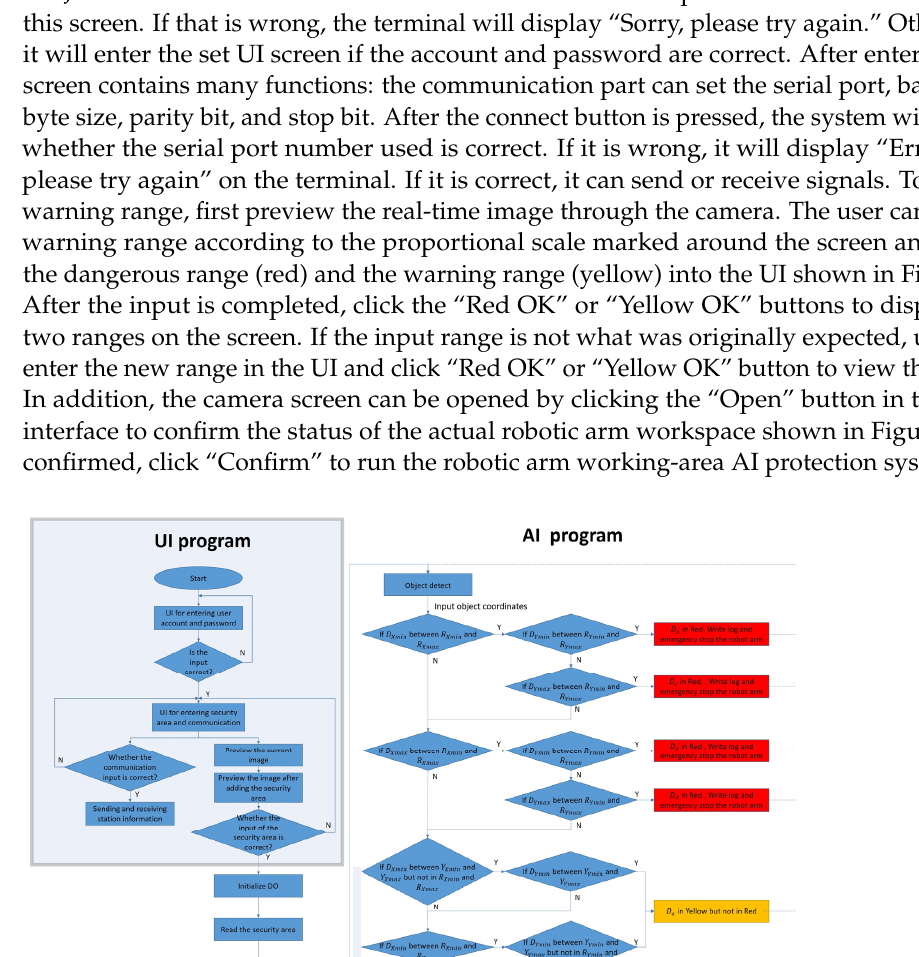
Figure 11. User interface after clicking the “open” button. 4.2. Actual Action—Open Robotic Arm Workstation In this section, the KUKA robotic arm grinding station is used as the implementation station. The user can use the “ifconfig” command to query the IP of the NVIDIA Jetson AGX Xavier, and enter the IP and port number in the browser. After the connection is successful, the system will start to detect and determine. When the autonomous mobile robot (AMR) enters the warning range or the dangerous range, the system will detect the AMR and turn on the green light to indicate that the AMR can grasp the object, as shown in Figures 12 and 13. When the person enters the warning range, the system will light up the yellow light to warn the person, as in Figure 14. If the person enters the dangerous range, the robot arm will be stopped urgently and the red light will be turned on, as shown in Figure 15, and the result will be recorded in the logfile folder for that day. The logfile contains text files and screenshots, such as in Figure 16, allowing users to check the current situation after the event to verify whether there has been a misjudgment or an accident, and if it is safe, the green light will turn on, as shown in Figure 17. When the light source is insufficient or the lens is dirty, the image quality will be reduced, leading to lower recognition rates. Just like general visual inspection systems, it is necessary to ensure the quality of camera images to avoid misjudgments caused by improper image acquisition.